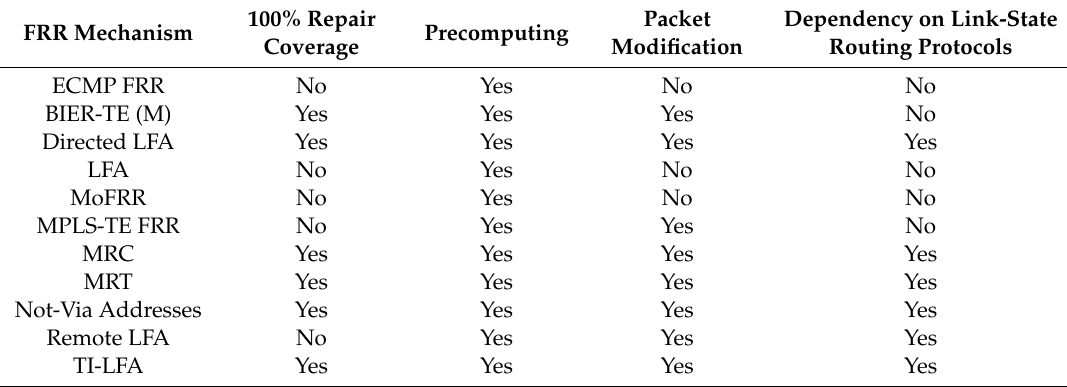
Table 1. FRR mechanisms: features